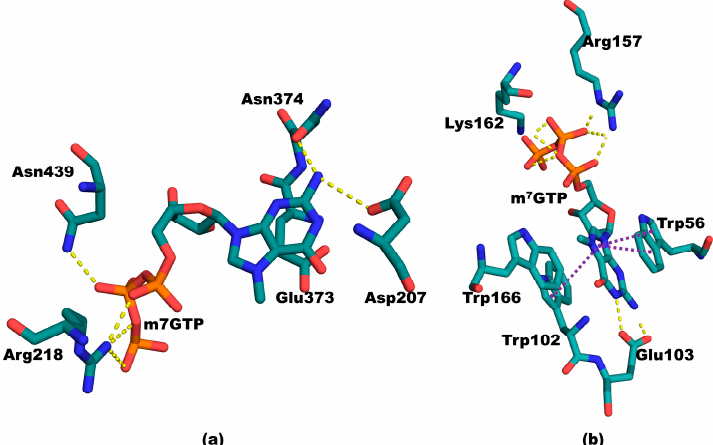
Figure 10. ( a ) M 7 GTP bound to the cap-binding site in the human cap-specific mRNA (nucleoside-2 ′ - O-)-methyltransferase 1 (pdb code: 4N49) [16] and ( b ) m 7 GTP bound to the Eukaryotic translation initiation factor 4E (eIF4E) cap-binding site (PDB code: 4TQB). Hydrogen bonds are shown with yellow dotted lines, and π - π interactions are shown with purple dotted lines [10,17,23,25].